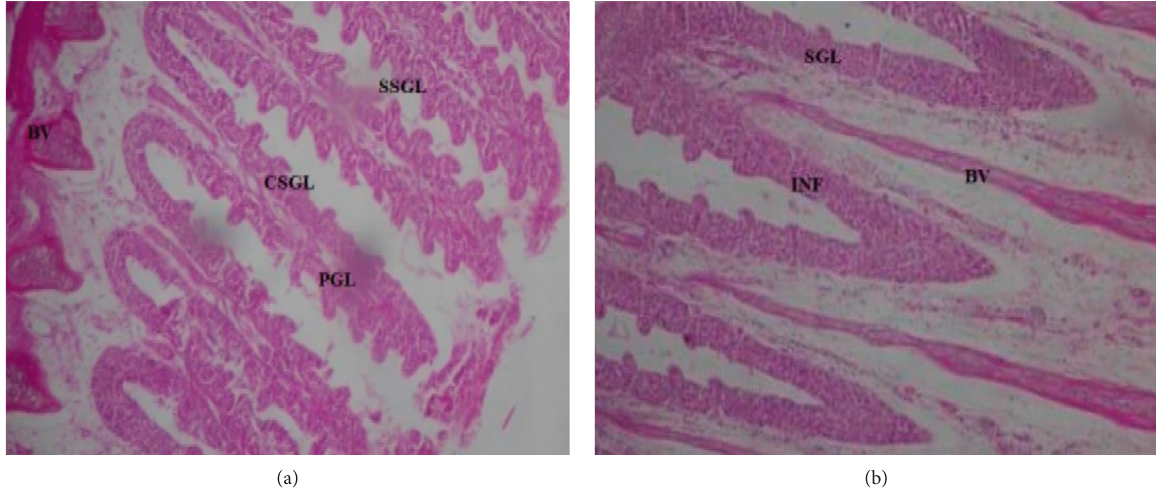
Figure 10: (a) Histological section of gill exposed to nano-Al 2 O 3 /CuO (1:2) showing primary gill lamella (PGL), curved secondary gill lamella (CSGL), and shortened secondary gill lamella (SSGL) (H&E stains, × 400). (b) Histological section of gill exposed to nano-SiO/CuO (1: 2) showing secondary gill lamella (SGL), inflammation of lamella (INF), and blood vessel (H&E stains, ×